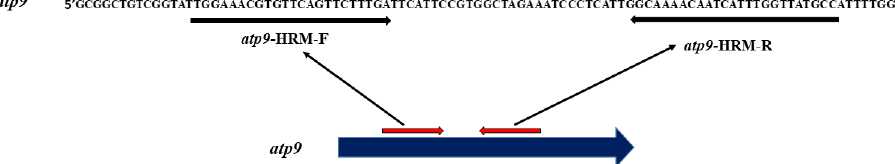
Figure 3. HRM primer annealing sites on orfA501 and atp9 gene sequences. Primer binding sites are indicated by horizontal